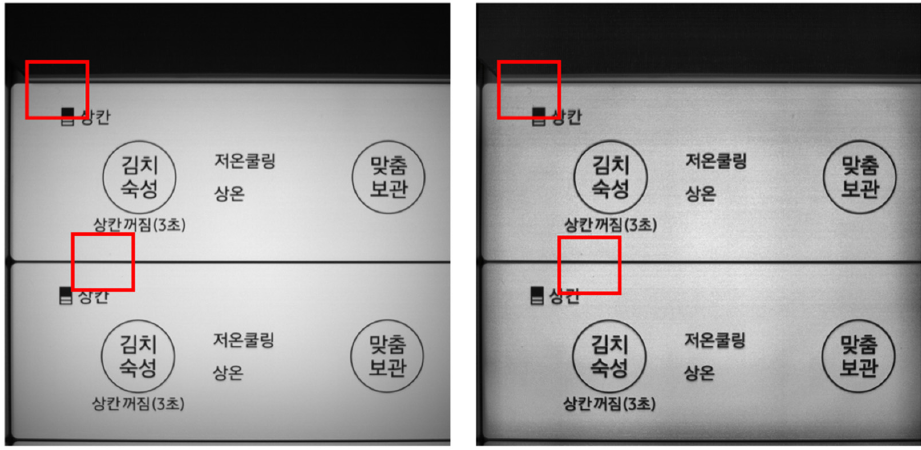
Figure 8. Improved contrast with contrast-limited adaptive histogram equalization (CLAHE) [28].